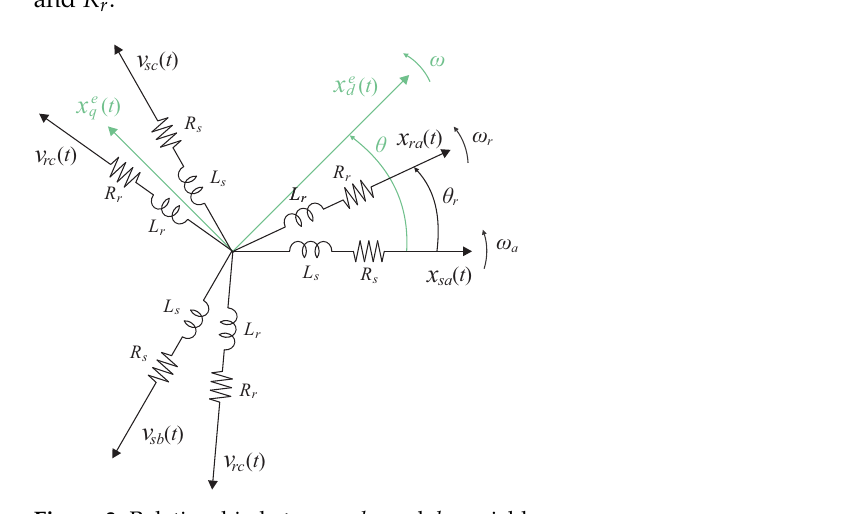
Figure 3. Relationship between abc and dq